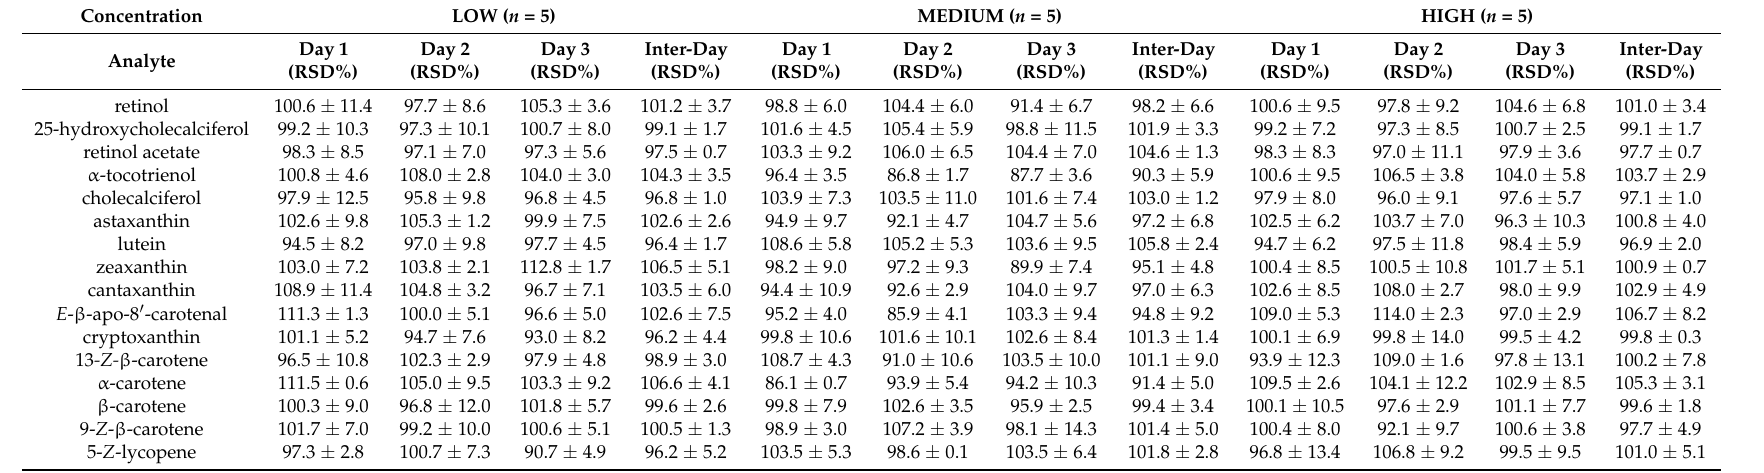
Values are expressed as means ± relative standard deviation; n : replicates; n =